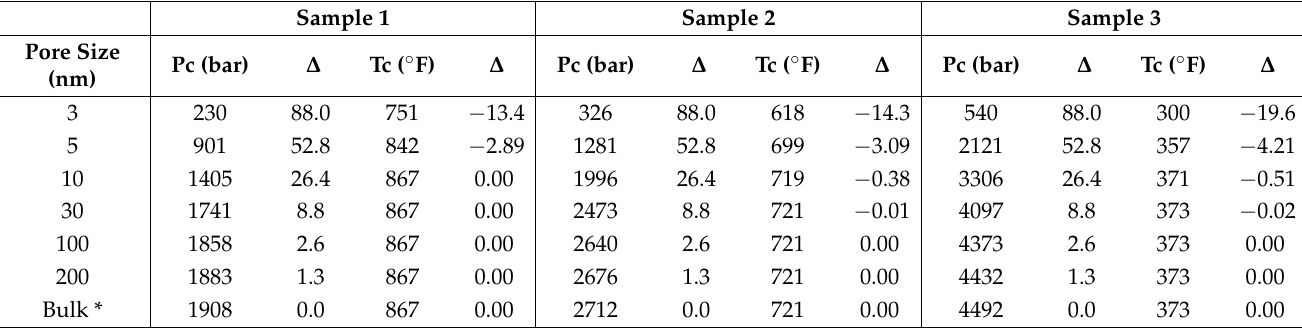
Table 4. The deviation in critical properties due to the pore confinement effect.